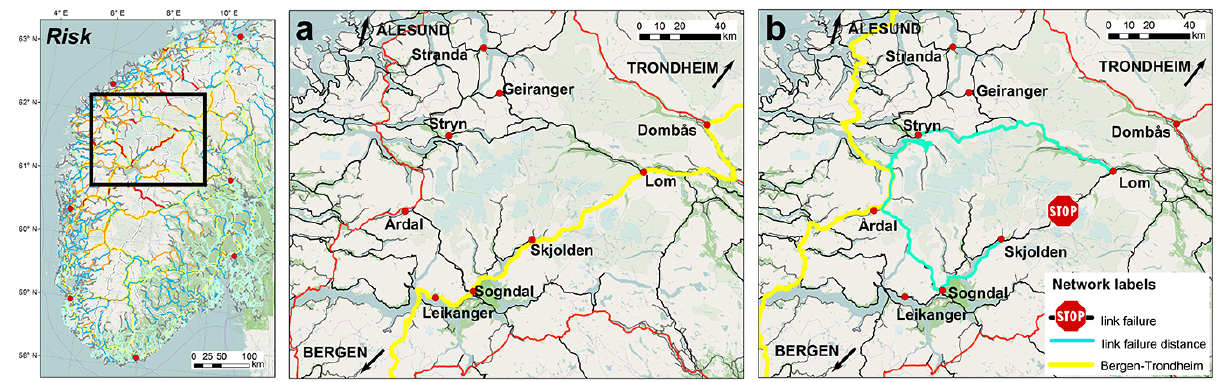
Figure 8. Illustration of network routing with (a) open access between Lom and Skjolden and (b) under temporary closure of road between the two cities. Legend to overview map is given in Fig.